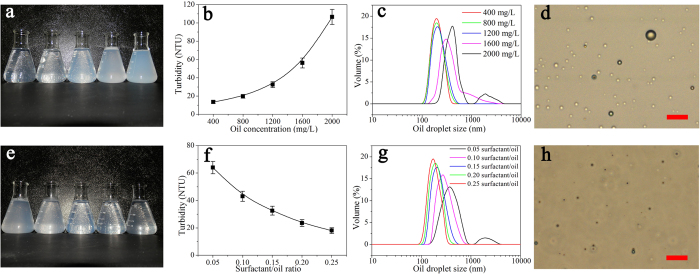
The characterizations of oil-in-water nanoemulsions.(a) Optical photo (from left to right, oil concentration is increased from 400 mg/L to 2000 mg/L by 400 mg/L increment for each flask), (b) turbidity data and (c) dynamic light scattering (DLS) result of nanoemulsions under different oil concentrations (The surfactant/oil ratio is kept as 0.15). (d) Optical microscopy image of 2000 mg/L nanoemulsion with 0.15 surfactant/oil ratio (scale bar, 2 μm). (e) Optical photo (from left to right, surfactant/oil ratio is increased from 0.05 to 0.25 by 0.05 increment for each flask), (f) turbidity data and (g) DLS result of nanoemulsions under different surfactant/oil ratios (The oil concentration is kept as 1200 mg/L). (h) Optical microscopy image of 1200 mg/L nanoemulsion with 0.15 surfactant/oil ratio (scale bar, 2 μm).